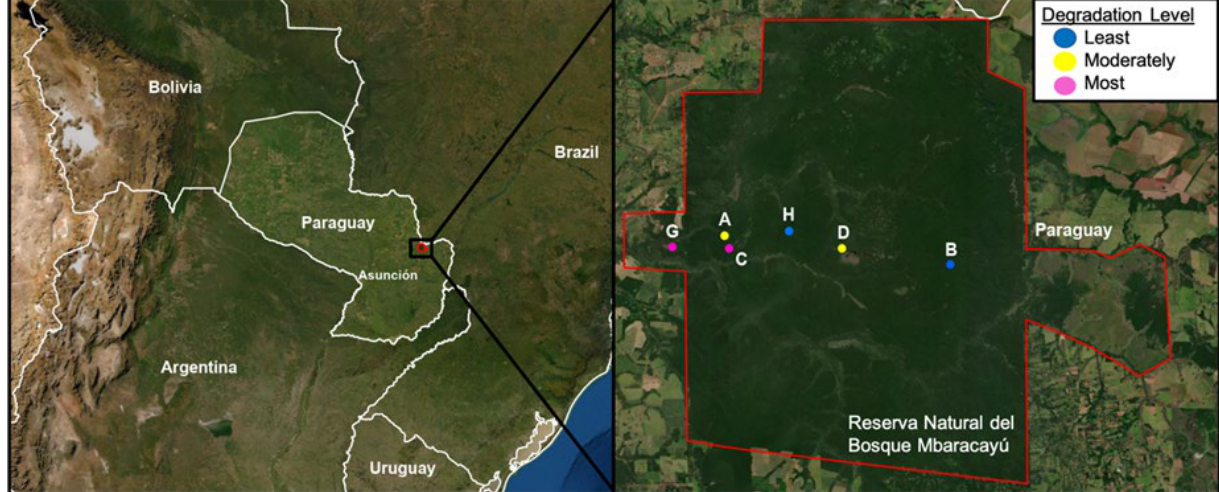
Figure 1. The left panel shows the location of the Reserva Natural del Bosque Mbaracayú (RNBM) in eastern Paraguay near the border with Brazil and is represented with a black box. In the right panel, an enlarged photograph of the RNBM is outlined in red, and the location of the grids is shown. Rodents were sampled from six grids (three enclosed—H, D, C) and three unenclosed—B, A, G). Grids were designated as “least degraded”—B and H, “moderately degraded”—A and D, and “most degraded”—G and C. The image was made using ArcGIS ® software by Esri. ArcGIS ® and ArcMap™ are the intellectual property of Esri and are used herein under license. Copyright © Esri. All rights reserved.